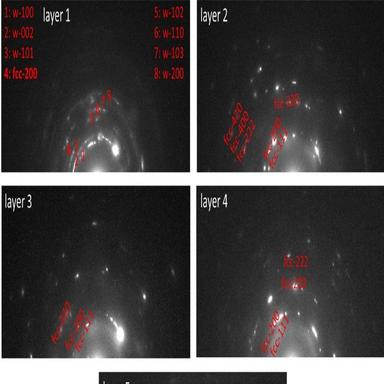
SAED patterns for all five individual layers of the graded TiAl(O)N film. Layer 1 shows a dominating w-structure, while for layer 2–5 only the fcc-phase can be observed. With increasing layer number the diffuse ring in the center becomes brighter, indicating an increasing amorphous phase fraction.